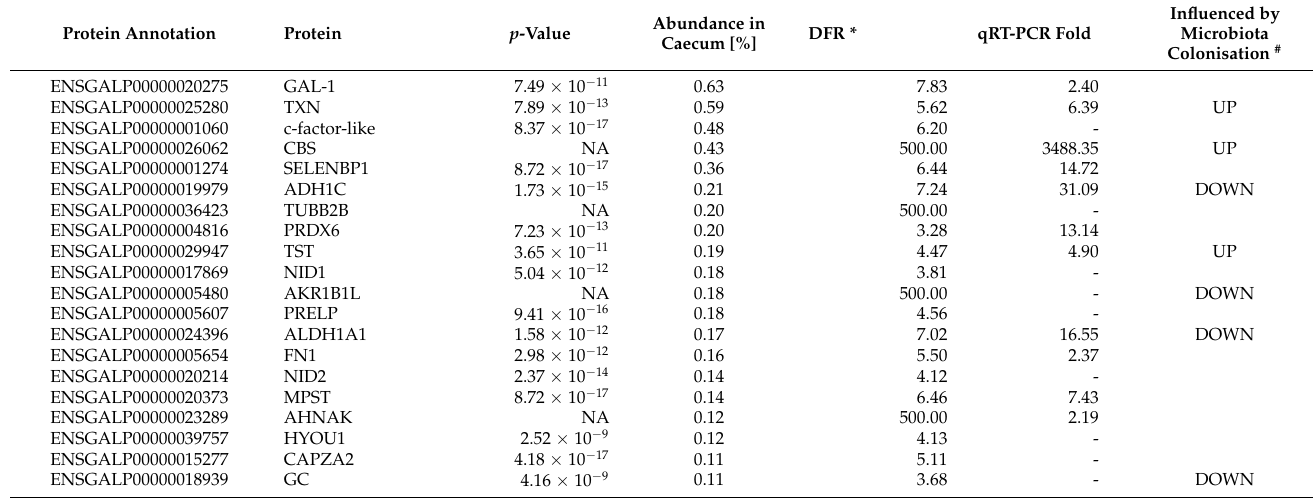
Table 3. The top 20 proteins specific for the caecum ranked according to